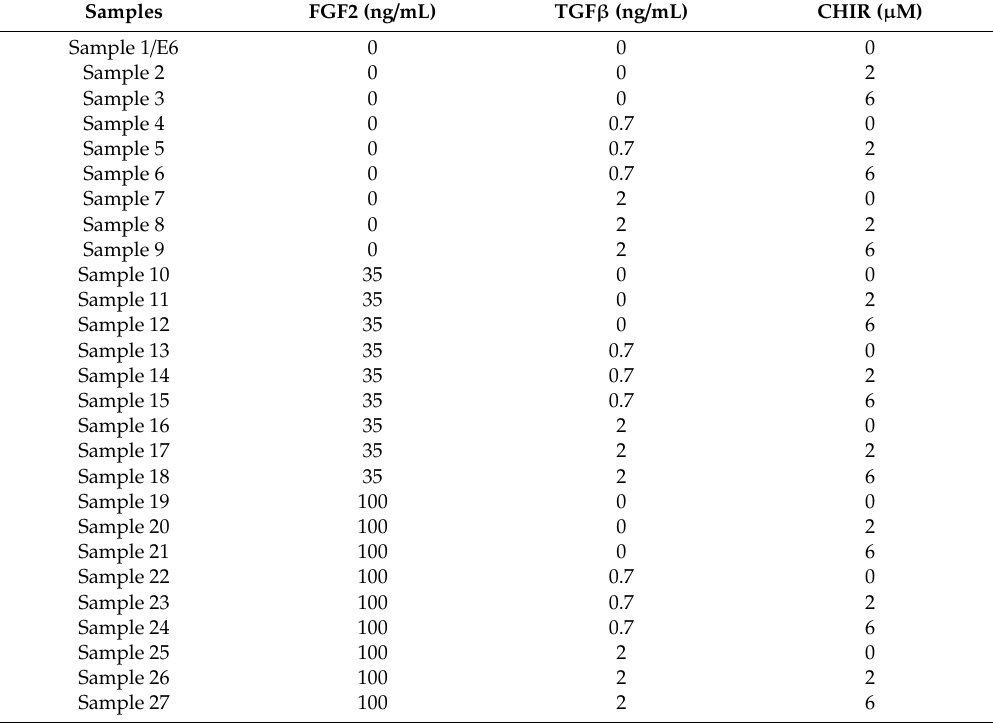
Table 1. Full factorial design conditions. FGF2 concentration levels ranged between 0, 35, and 100 ng / mL; TGF β concentration levels ranged between 0, 0.85, and 2 ng / mL; and CHIR concentration levels ranged between 0, 2, and 6 µ